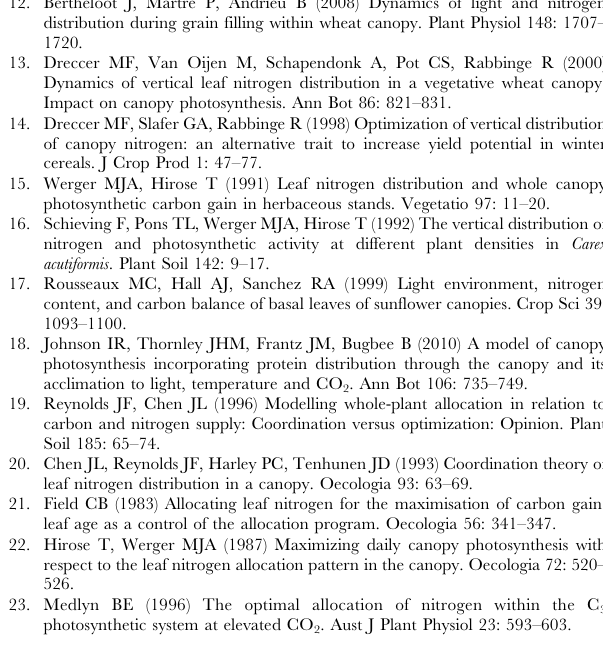
(Table S4). Characteristics of the relationship between predicted and observed leaf N content ( N ac / N a , gN m 2 2 ). The intercepts of regression for each PFT were set to zero (since there were not significantly different from zero) to estimate the slopes. Abbrevi- ation: RRMSES and RRMSEU are systematic and unsystematic relative root mean square error, respectively. Table S7 Dependence of leaf photosynthetic parame- ters on plant functional type (PFT). ANOVA model and mean comparison test by LSD method of the PFT effect on leaf photosynthetic traits used in the test of coordination hypothesis ( V C , J max , k 3 , J fac and SLA ). The values of k 3 and J fac were log- max transformed and all residuals followed a normal distribution. For a given variable, PFTs with the same letter belong to the same group. (DOC) Text S1 Sensitivity analysis of the photosynthesis – stomatal conductance model. (DOC) Text S2 Demonstration of the formalism of the coordi- nated leaf photosynthetic N